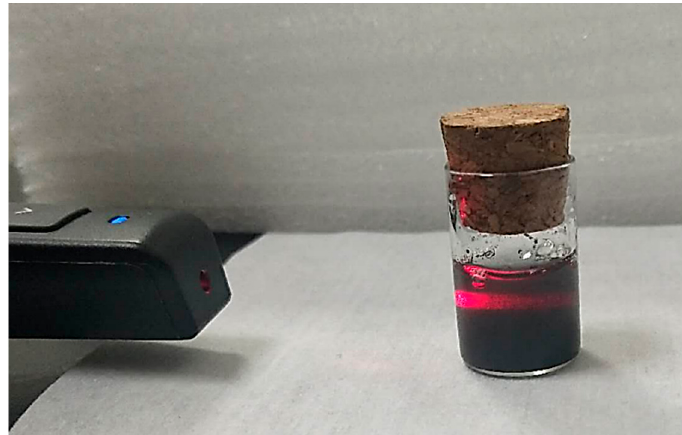
Figure 2. Photograph demonstrates the occurrence of Tyndall effect.